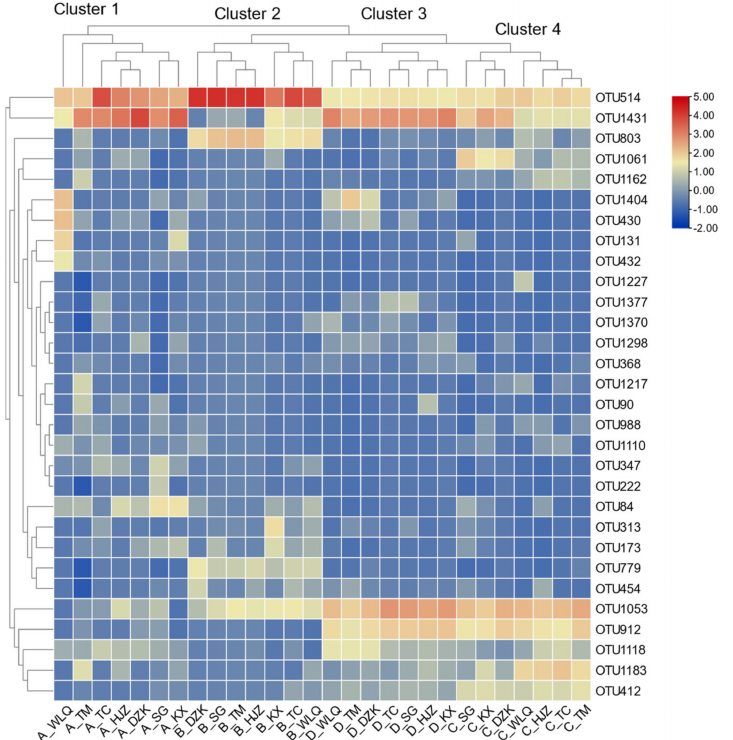
Figure 3. Four season cluster diagram of diatoms in Danjiangkou Reservoir (bottom horizontal axes: A is spring samples, B is summer samples, C is autumn samples, and D is winter